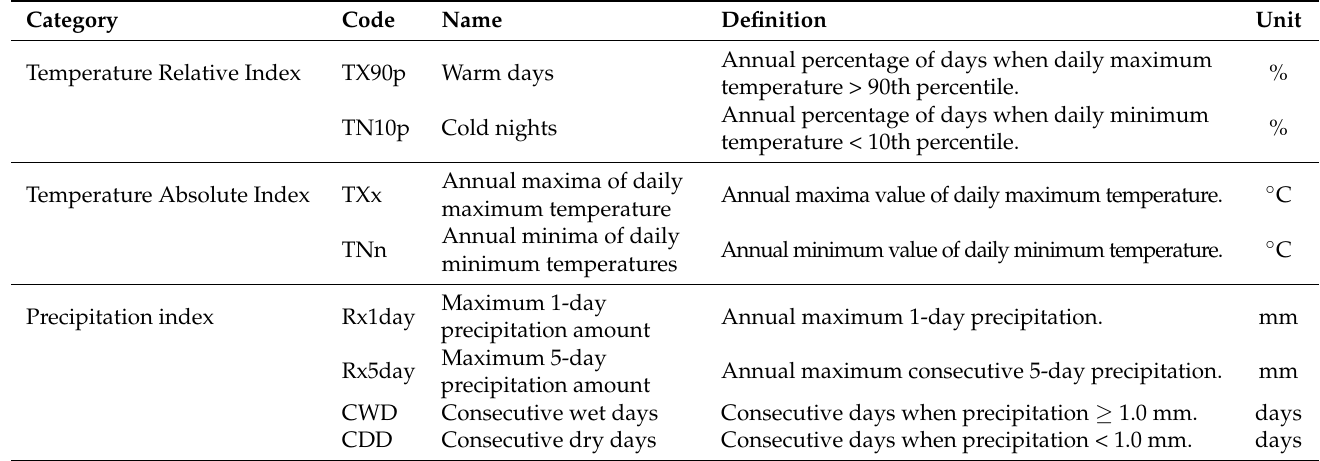
Table 1. Definition of extreme